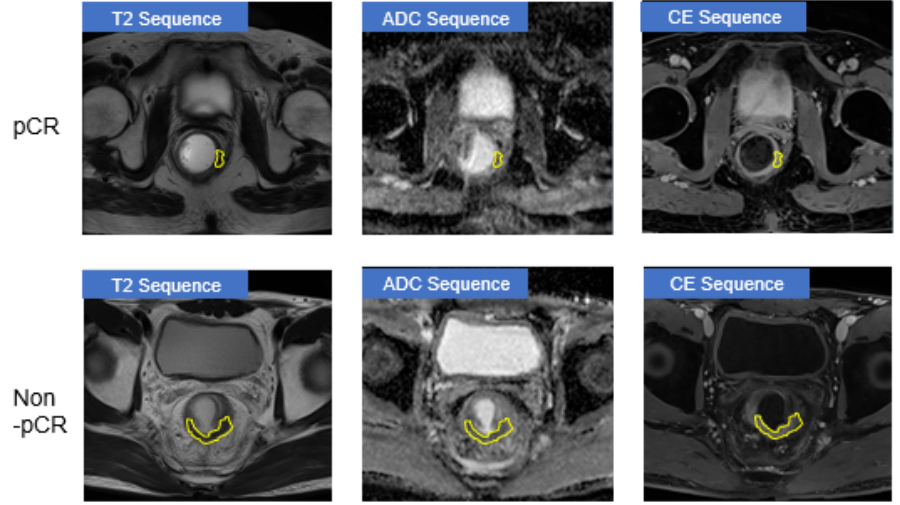
Figure 1. Three types of MRI images { T2, DWI/ADC, and CE } of a pCR patient ( upper ) and a non-pCR one ( lower ). Yellow masks are rectal tumor areas segmented and validated by